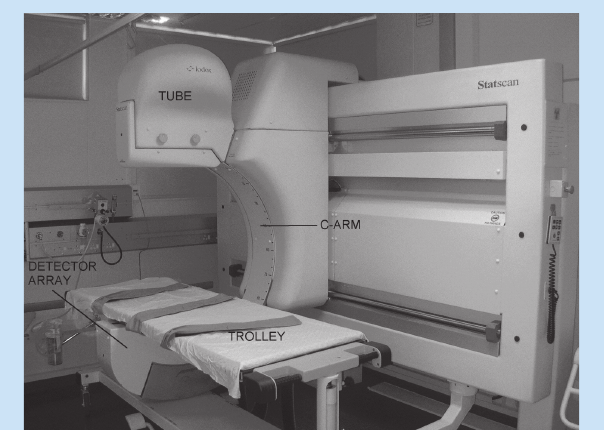
Fig.1. The Statscan machine and its main